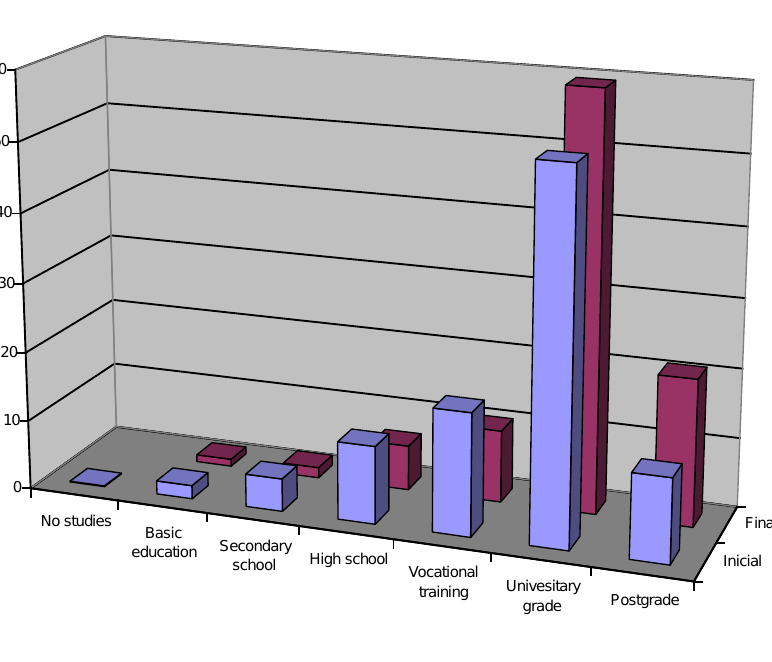
Figure 3. Respondents by level of education and initial/final survey.